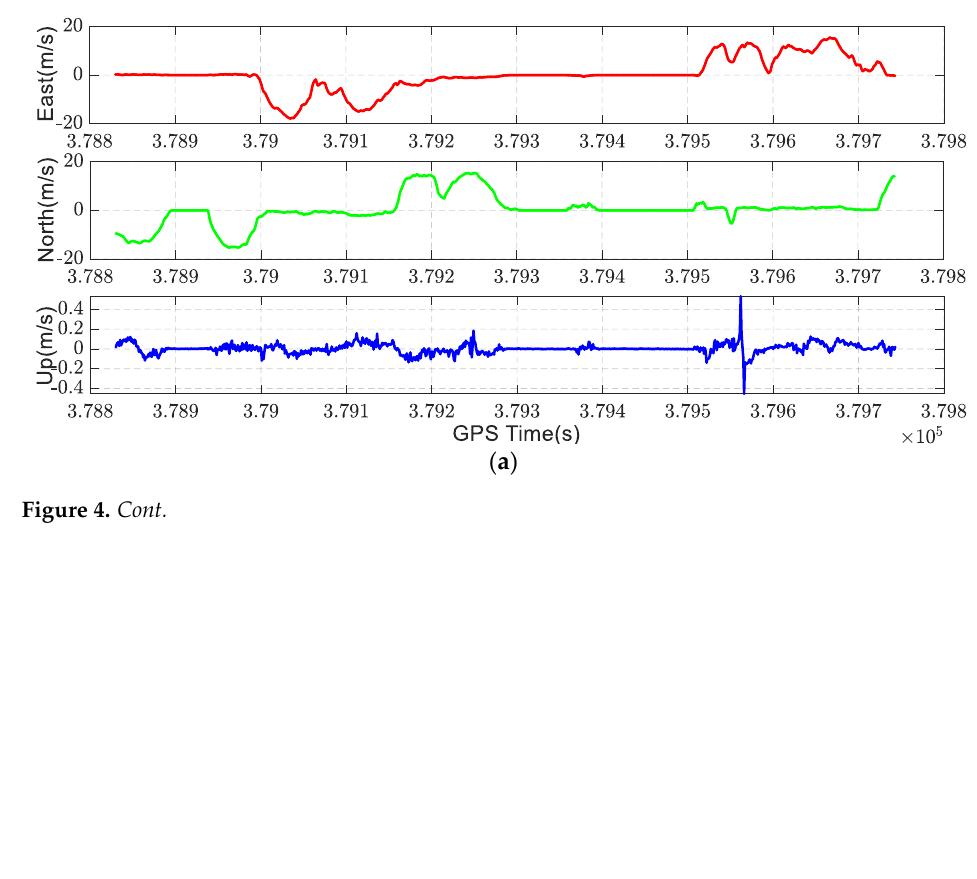
Figure 4. The vehicular speed and attitude in the field test: ( a ) the vehicular speed; and ( b ) the ve- hicular attitude. The experiment collected satellite observation data of the GPS, BDS-2, and BDS-3 sys- tems. Among them, GPS and BDS-2 have triple-frequency observation data, namely L1, L2, and L5 and B1, B2, and B3 respectively. BDS-3 has four-frequency observation data, namely B1C, B1I, B3I, and B2a. In the process of data processing, triple-frequency EWL/WL linear combination was constructed for triple-frequency observations, and four- frequency EWL/WL linear combination was constructed for four-frequency observations. Among them, the EWL and WL combinations of triple-frequency GPS/BDS-2 are (0, − 1,1) and (1, − 1,0), respectively, and the EWL combination of pseudorange is (0,1,1). The selec- tion of the above EWL/WL combination can be referred to [40]. To research the influence of BDS-3 four-frequency observations on GNSS/INS tightly coupled positioning, firstly, the signal quality of GPS/BDS-2 triple-frequency observations and BDS-3 four-frequency observations in this experimental environment were given, including the number of visi- ble satellites and corresponding position dilution of precision (PDOP), as well as the sig- nal-to-noise ratio (SNR) of satellite observations. Secondly, the single epoch EWL/WL am- biguity resolution was analyzed, due to the different observation quality of triple-fre- quency data and four-frequency data, their ambiguity resolution will also be different. Finally, GNSS/INS tightly coupled positioning results with or without BDS-3 four-fre- quency observations were given.